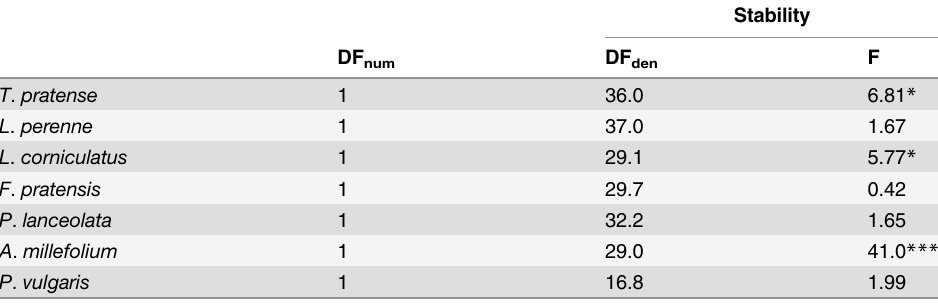
Table 2. ANOVA results for effects of soil inoculum on biomass